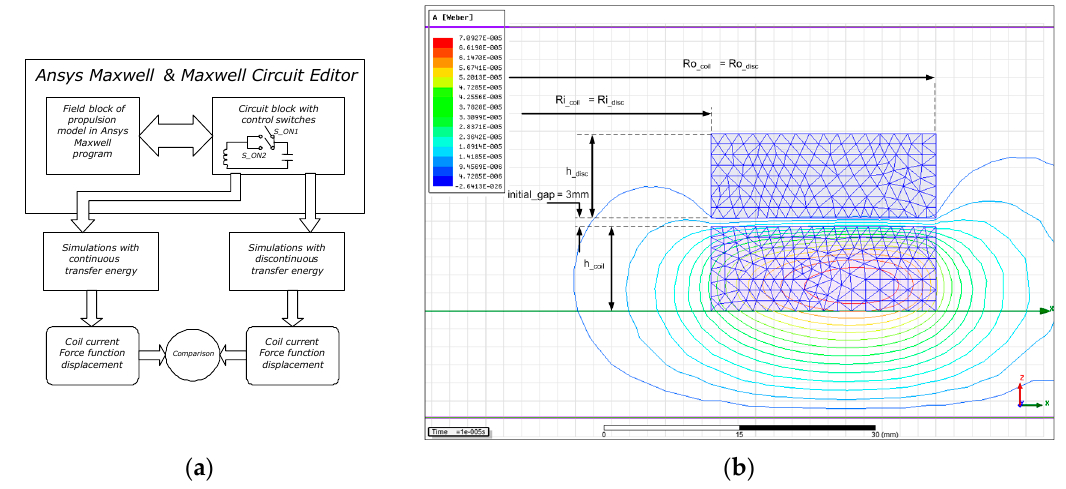
Figure 6. IDD model in the Ansys–Maxwell program: ( a ) Block scheme of the presented simulation examinations, ( b ) Flux density results in actuator model in Maxwell. Table 1. Propulsion (IDD)